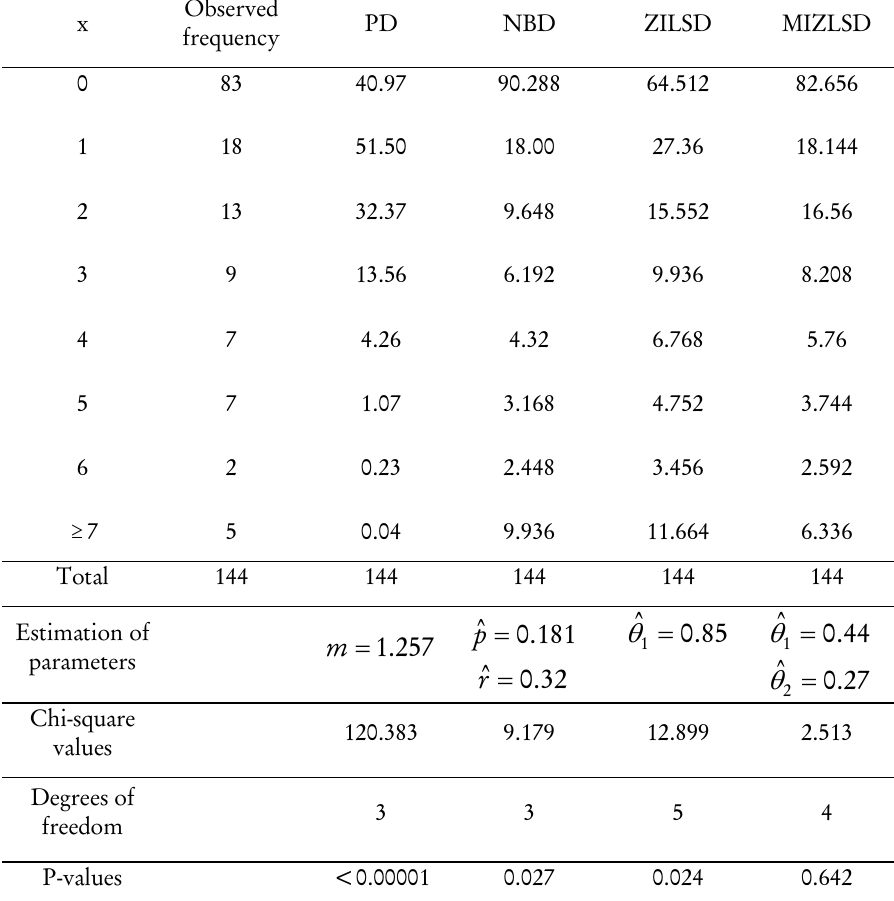
Observed frequencies and computed values of expected frequencies of the PD, the NBD, the ZLSD and the MZILSD by method of maximum likelihood for the first data